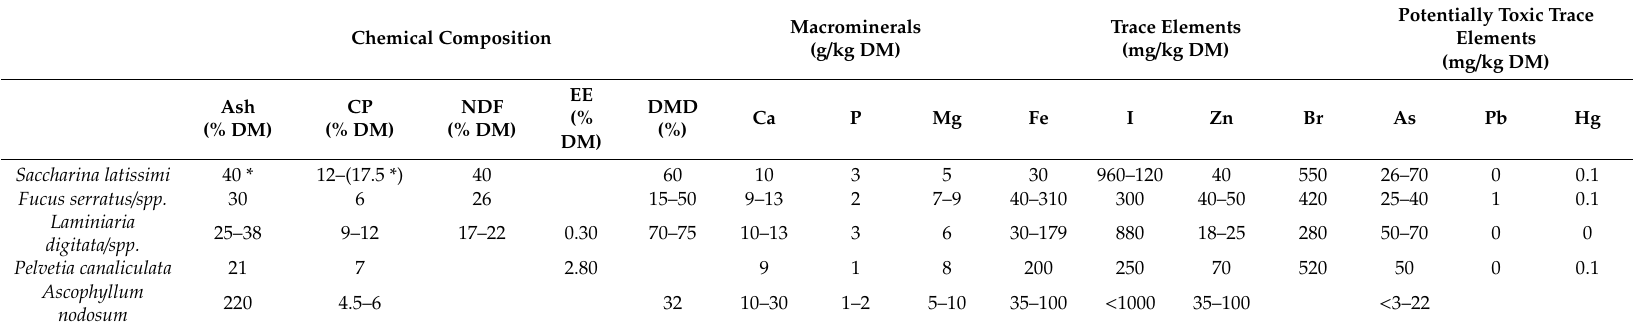
Table 2. Chemical composition and macro minerals, trace elements and potentially toxic elements of brown